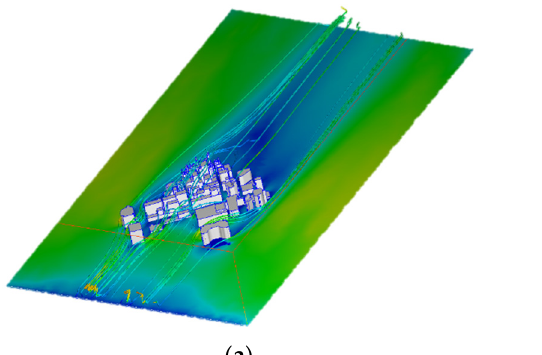
Figure 15. Computational fluid dynamics simulation results. ( a ) Grid of the basic urban model, ( b ) Grid of the urban model with modular buildings.